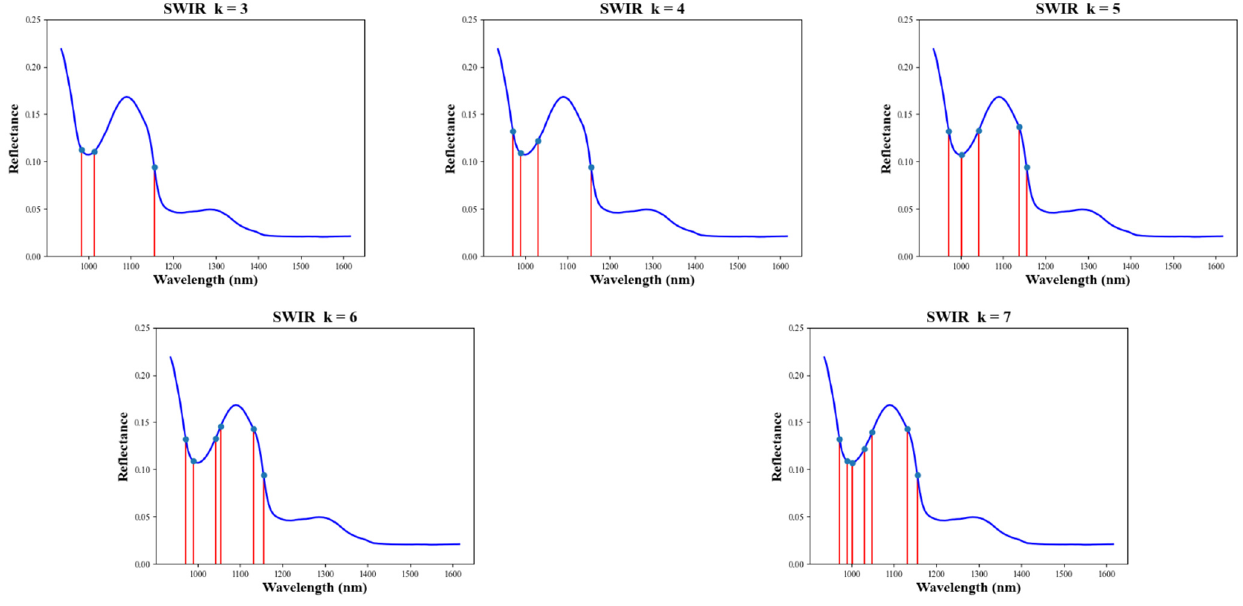
Figure 9. Average SWIR reflectance spectrum for one of the red snapper fillets with the optimal k = 3, 4, 5, 6, 7 wavelength selections.